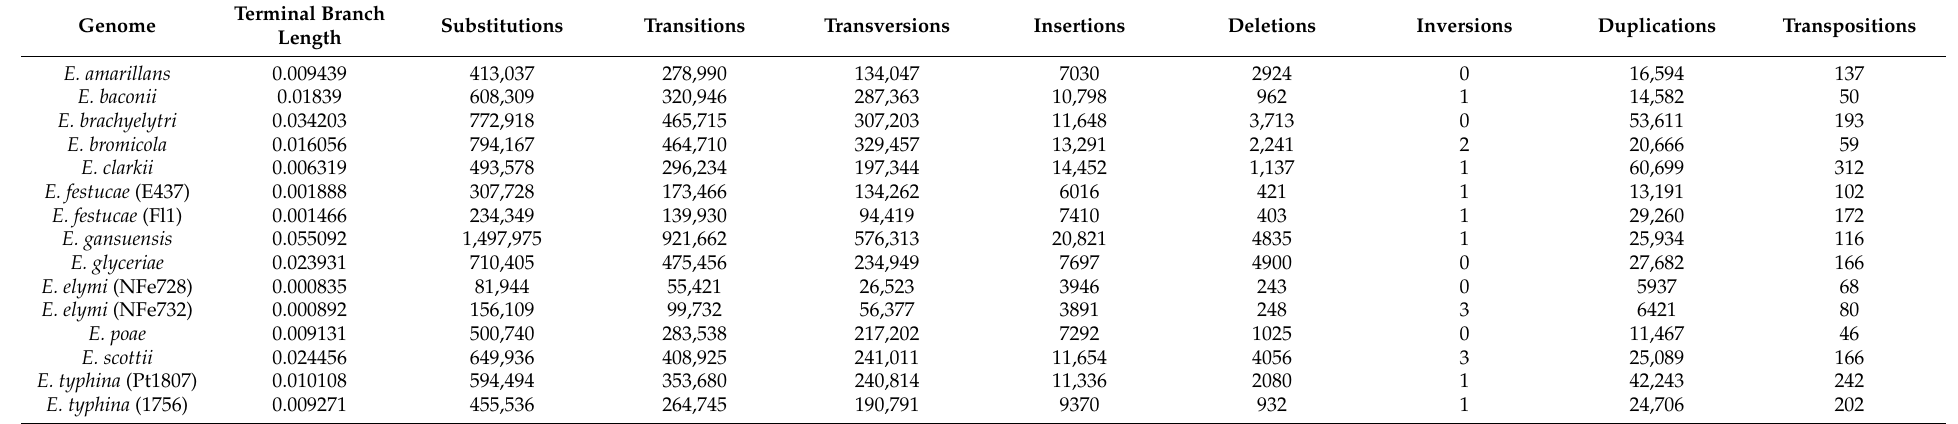
Table 3. Numbers of each mutation class accumulated on terminal branches of the Epichloë phylogeny, between ancestral and extant genomes.